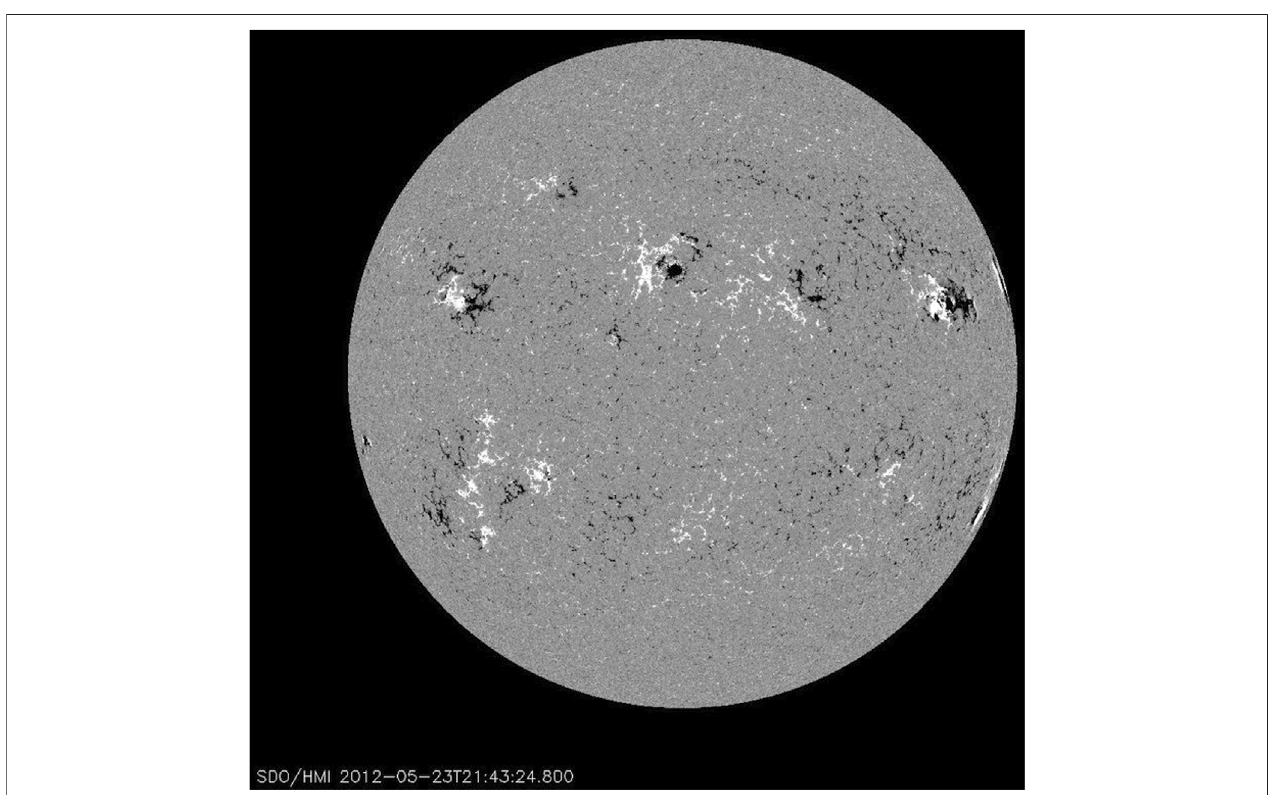
FIGURE 2 | Magnetograms show maps of the magnetic fi eld on the Sun ’ s surface, with black showing magnetic fi eld lines pointing away from Earth, and white showing magnetic fi eld lines coming toward Earth. Image Credits: NASA/SDO/Goddard.